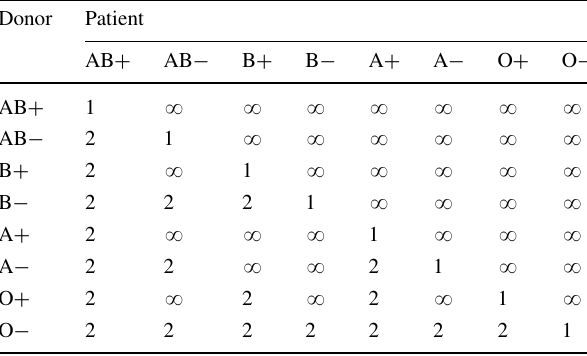
Table 1 Possible ABO/ Rh (D)-compatible substitutions for red